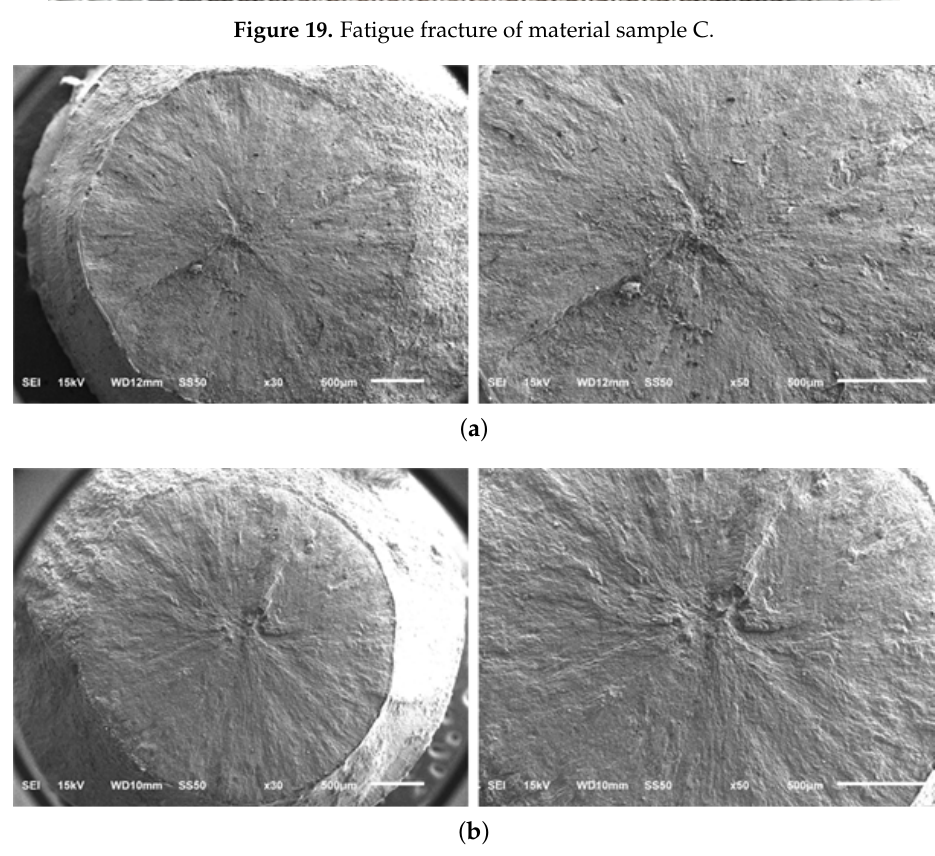
Figure 20. SEM micrographs of fatigue fractured surface of material sample C. ( a ) Stress amplitude 575 MPa and no. of cycles to failure 9.24 × 10 7 ; ( b ) Stress amplitude 650 MPa and no. of cycles to failure 4.7 × 10 6